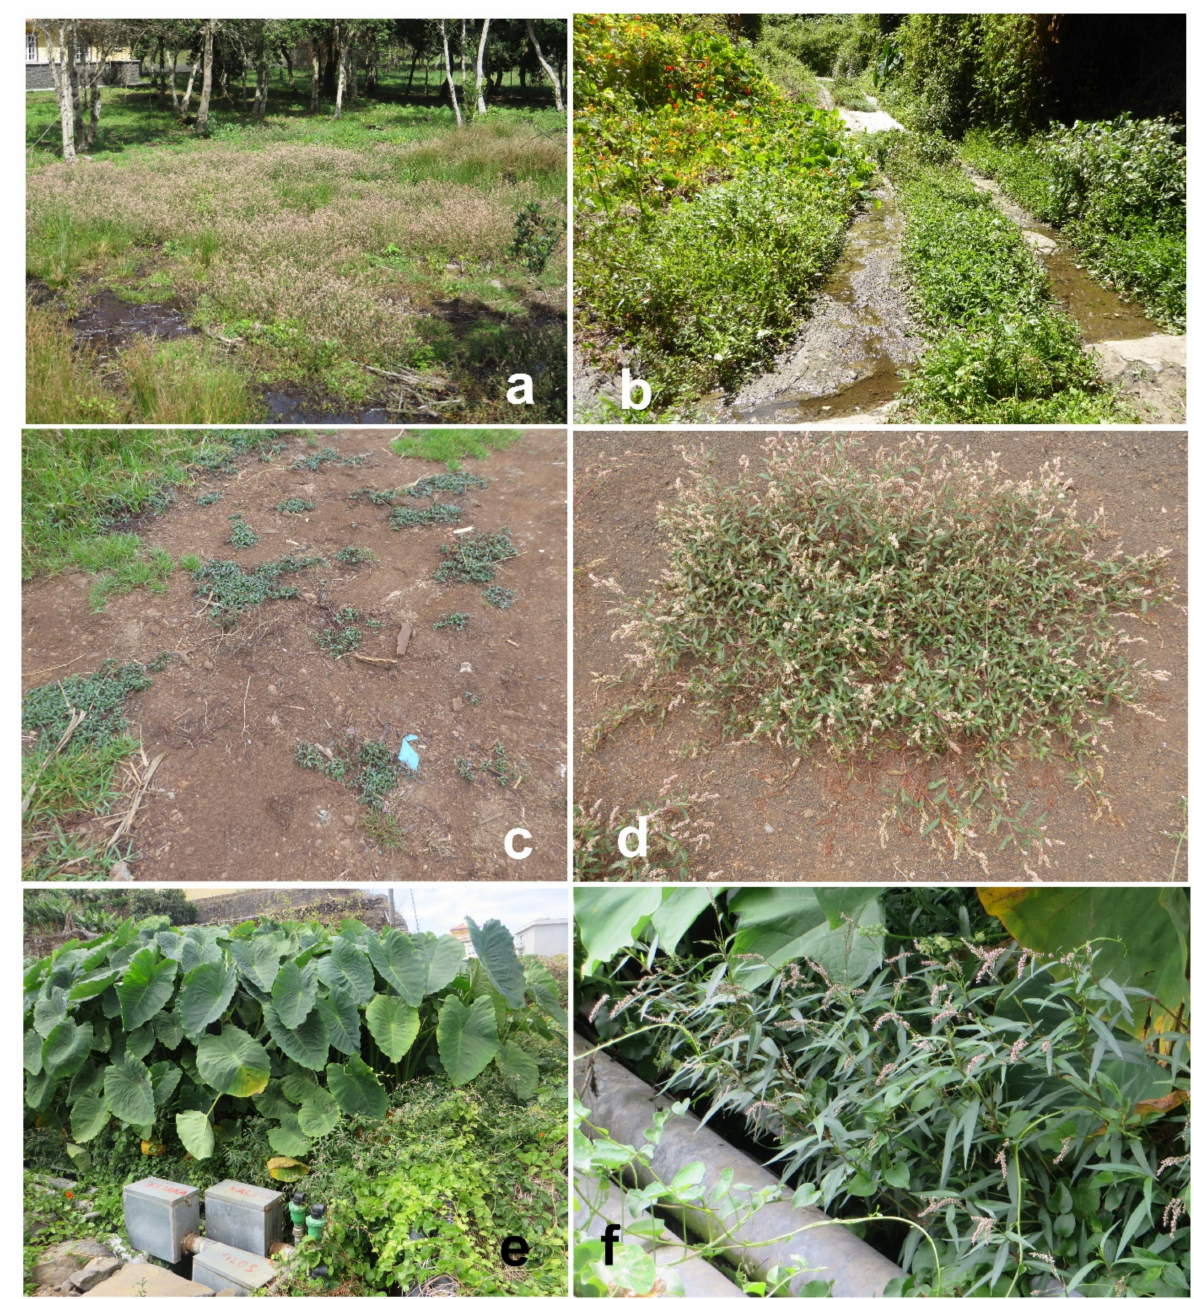
Figure 4. Persicaria hydropiperoides in La Palma: ( a ) mass occurrence under semiaquatic to moist conditions, Laguna de Barlovento close to the campsite, October 2015; ( b ) typical location of P. hydropiperoides in the Barranco San Juan near the mouth, April 2017; ( c ) pioneer situation and mass occurrence in pure stock on a landfill for soil excavation, Laguna de Barlovento, December 2013; ( d ) single plant with several decumbent and semi-erect shoots out of the same rhizome (see Figure 1(5b)) forming a cushion shaped structure ca. 50 cm high and ca. 120 cm diameter, Barlovento, August 2014; ( e , f ) occurrence in water channels in the growing area of Colocasia esculenta , Los Sauces, August 2014 (Photographs: R.